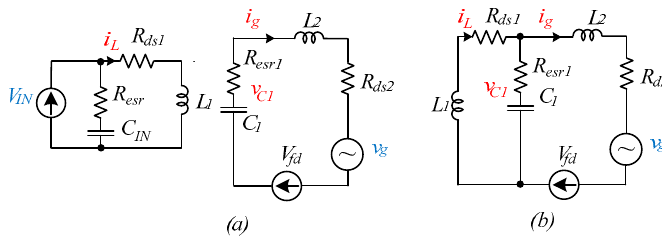
Figure 4. Equivalent circuits of a twisted buck-boost converter-based unfolding: on-state of forward transfer ( a ), on-state of reverse transfer ( b ).